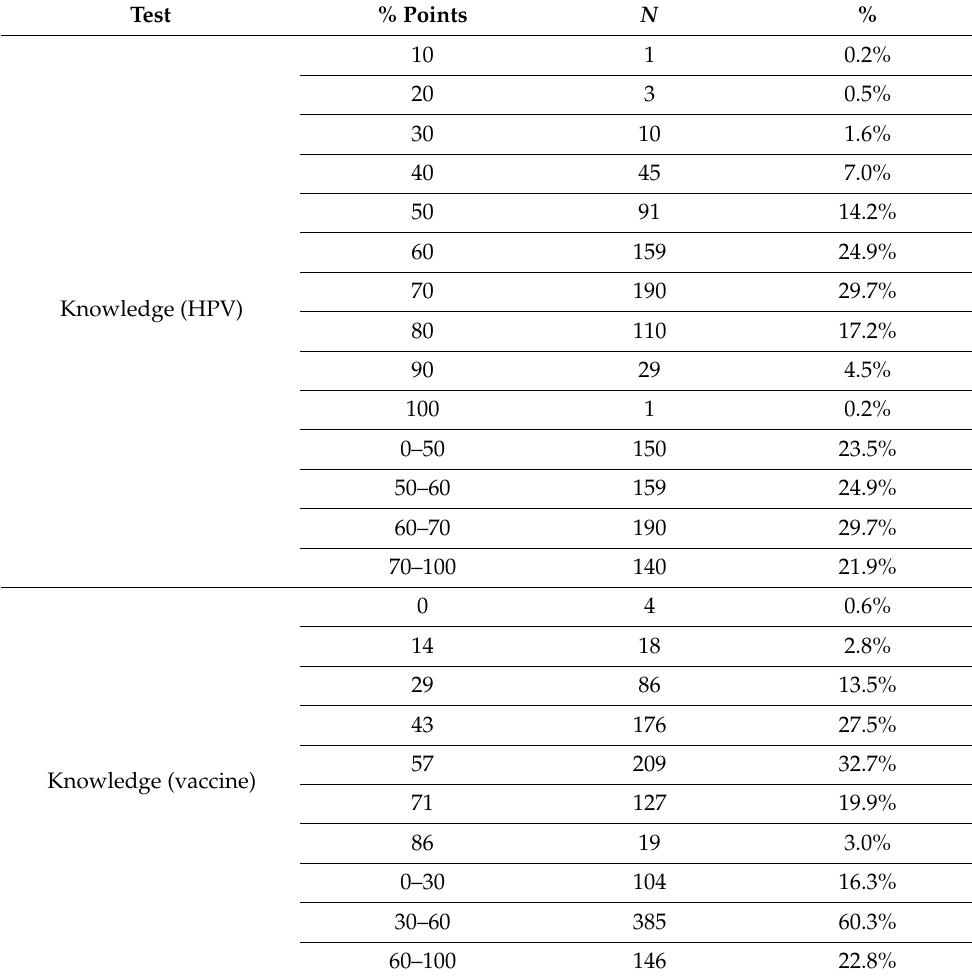
Table 4. Summary test results of HPV knowledge and vaccine